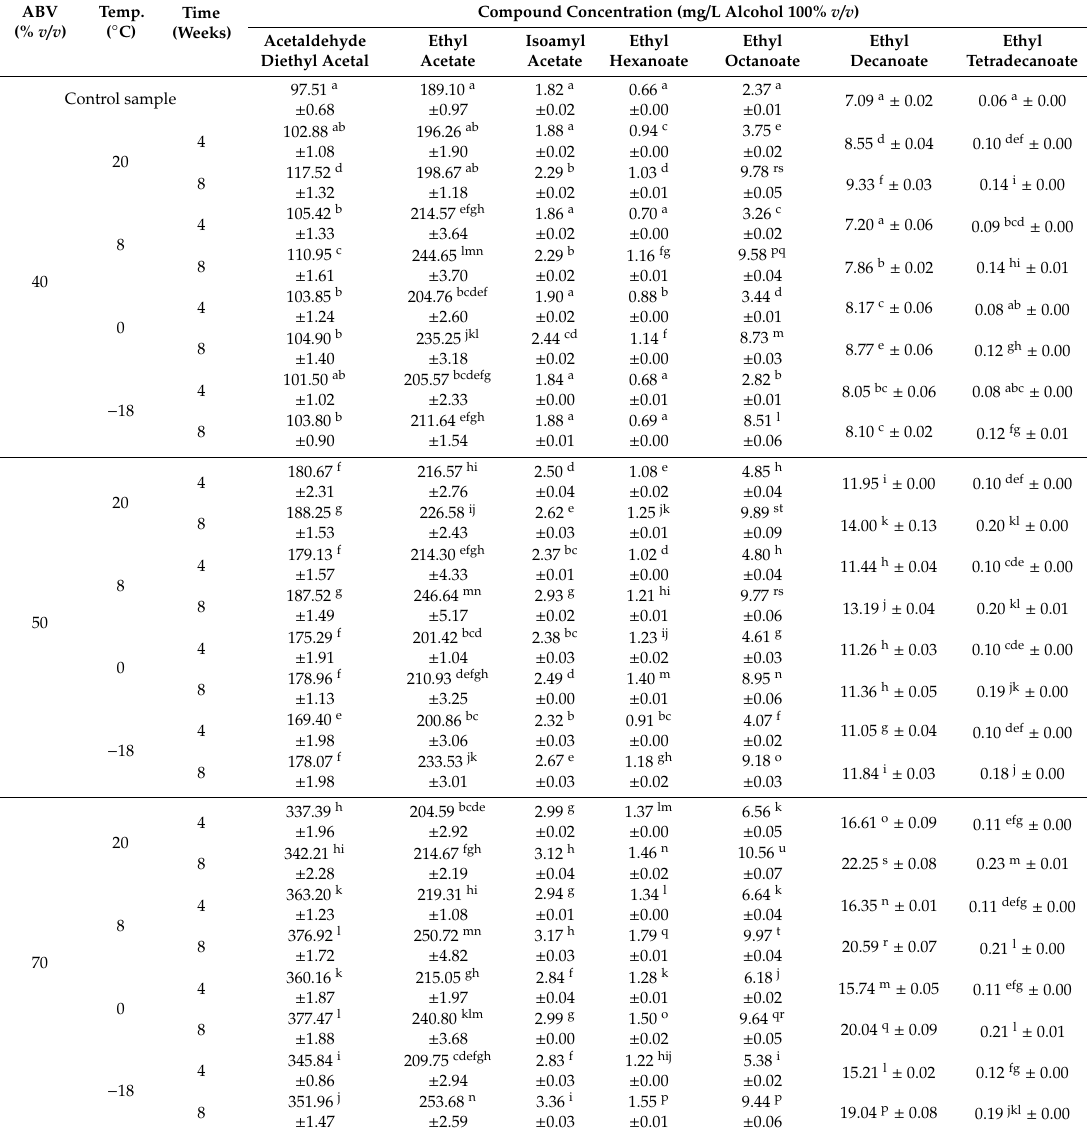
Table5. Changesinacetalsandestersinplumdistillatesamplesduringstorageatdi ff erenttemperatures. ABV Temp. (% v / v ) ( ◦